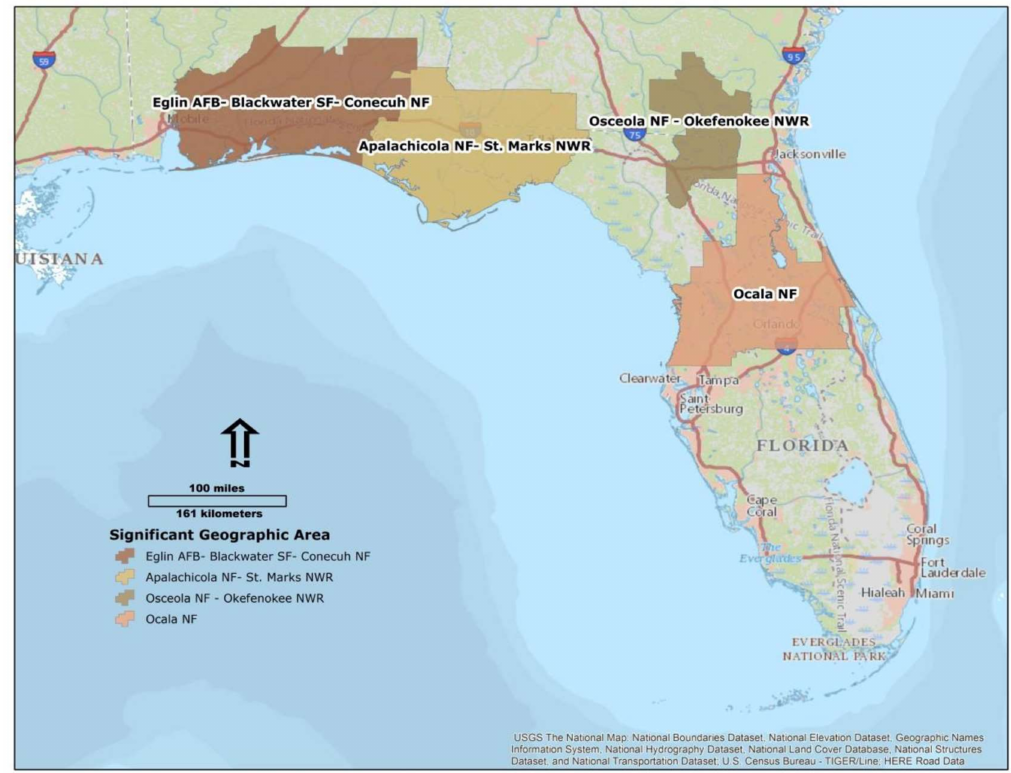
Figure 1. Extent of the study and corresponding significant geographic